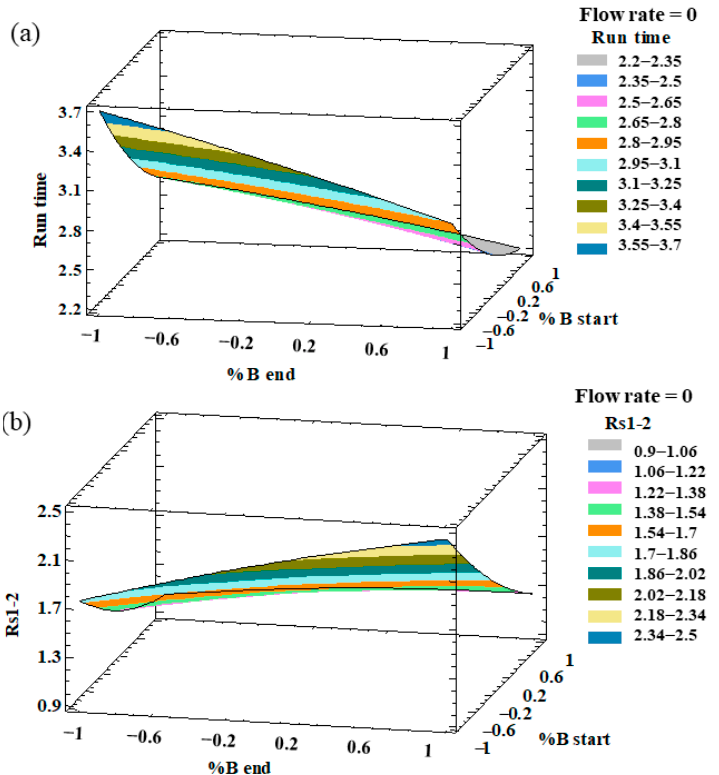
Figure 1. 3D surface plots of the Box–Behnken design to represent the influence of ( a ) %B at the end of the gradient–%B at the beginning of the gradient on the run time; ( b ) %B at the end of the gradient–%B at the beginning of the gradient on the resolution of peaks 1 and 2 (R S1–2 ). Subsequently, the MRO was used for the simultaneous optimization of the six re- sponses. All the responses were considered to be equally important chromatographic characteristics for the separation and determination of the flavonols. The weight of each response in the computational analysis was determined by the impact coefficient that had been assigned to each response by the MRO. The run times obtained in the 15 BBD experiments varied between 2.210 and 3.699 min. This run time range was considered as acceptable for rapid separations, especially when compared to the analysis run times of the UHPLC methods for onion flavonols published in the literature. Although some methods require a time as relatively short as 15 min [24,25], most of them require at least 30 min to complete the correct separation of all the peaks [6,11], and some of them may even need as much as 60 min [17,18]. However, the impact for this variable was set to the highest relevance (5 impact), since one of the main objectives of this work was to develop a time-and-cost-saving multiple analysis UHPLC methodology. With regards to the resolutions, all the R S4–5 (ranging from 2.46 to 5.40) and R S5–6 (ranging from 2.12